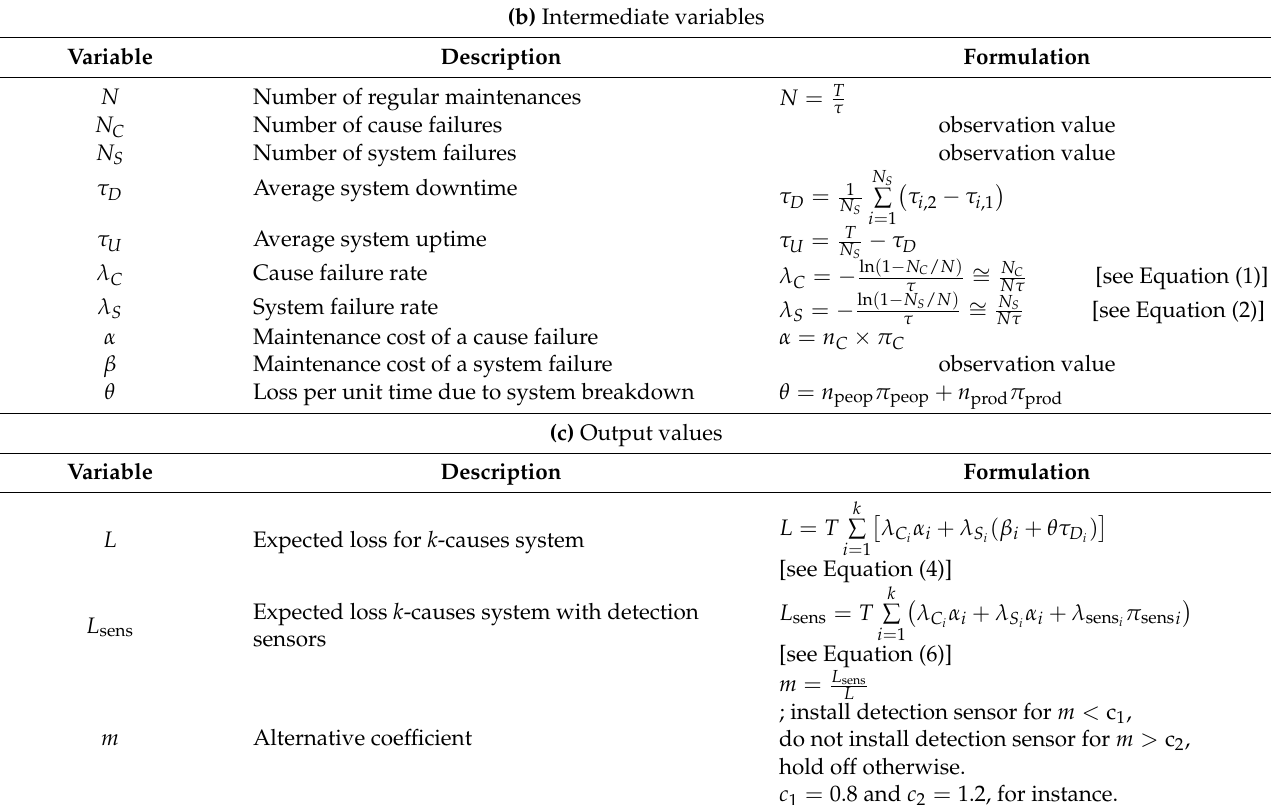
Table 1. Cont. (b) Intermediate variables